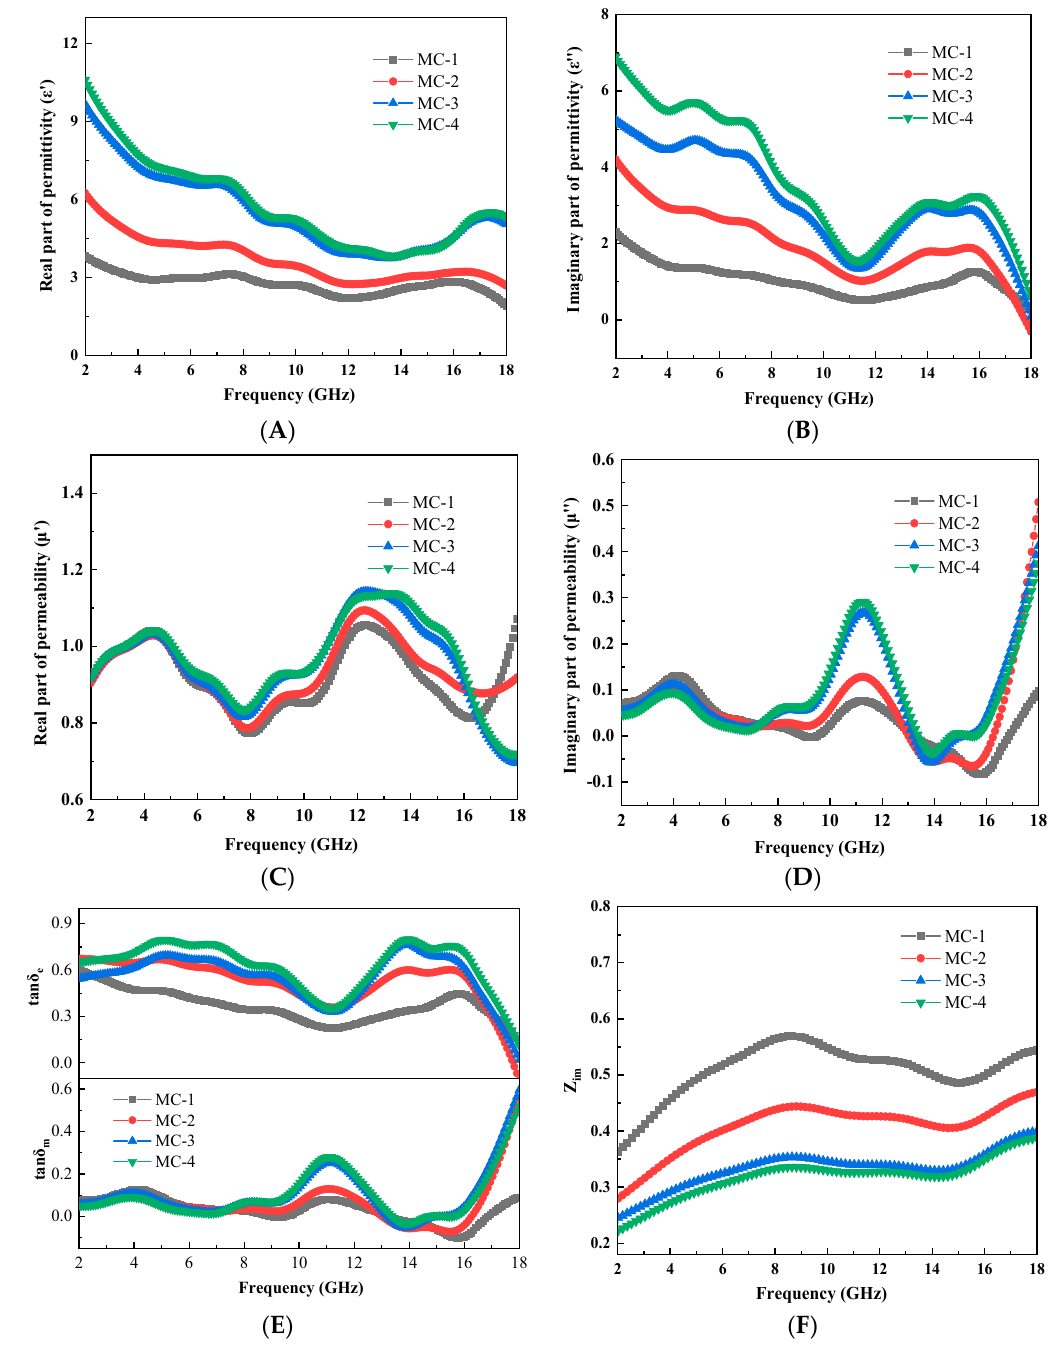
Figure 8. Parameters: the real parts of the complex permittivity for C/Fe 3 O 4 composite microspheres ( A ); the imaginary parts of the complex permittivity for C/Fe 3 O 4 composite microspheres ( B ); the real parts of the complex permeability for C/Fe 3 O 4 ( C ); the imaginary parts of the complex permeability for C/Fe 3 O 4 ( D ); dielectric loss and magnetic loss curve ( E ); impedance matching curve ( F ).